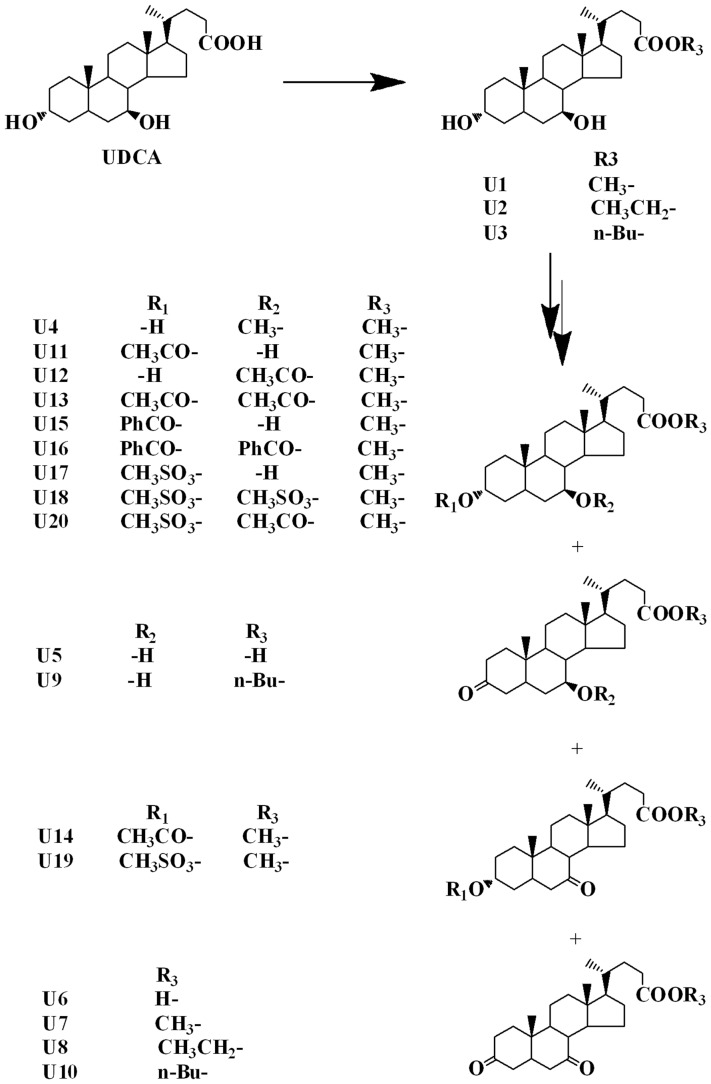
Chemical structures of UDCA and its derivatives.